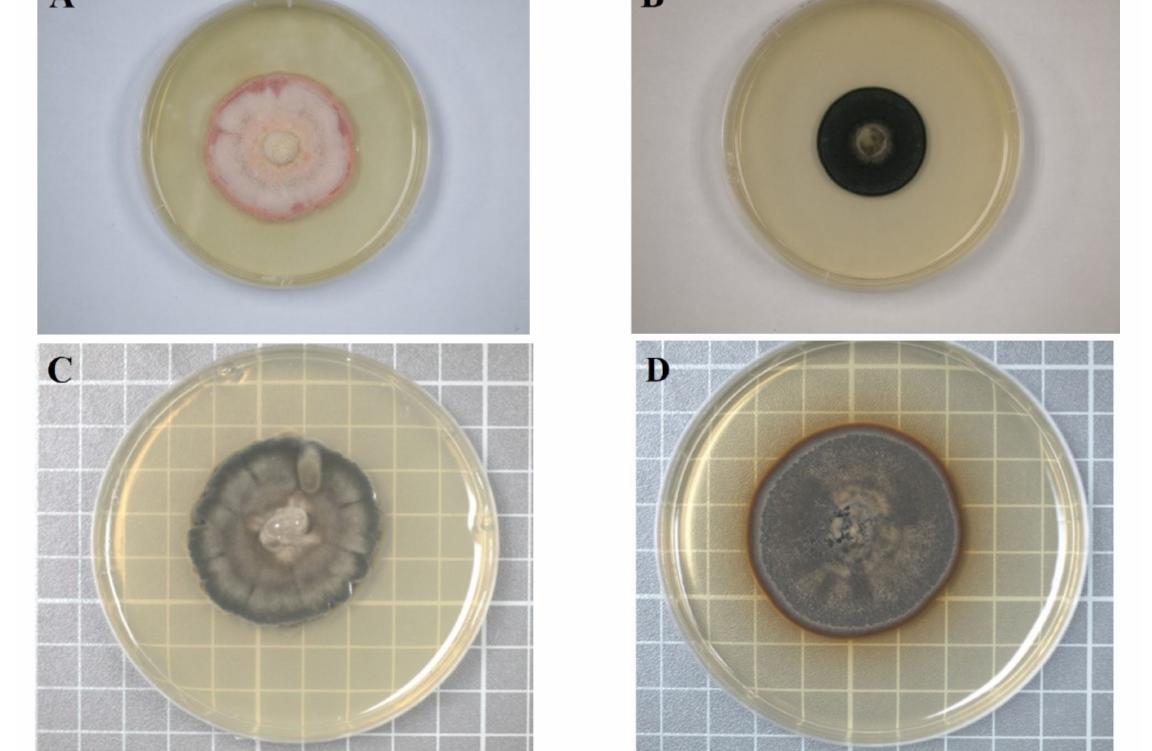
Figure 4. Colony morphology of these four strains on PDA medium. ( A ): MoAL2; ( B ): MoAL5; ( C ): CkDB2; ( D ):